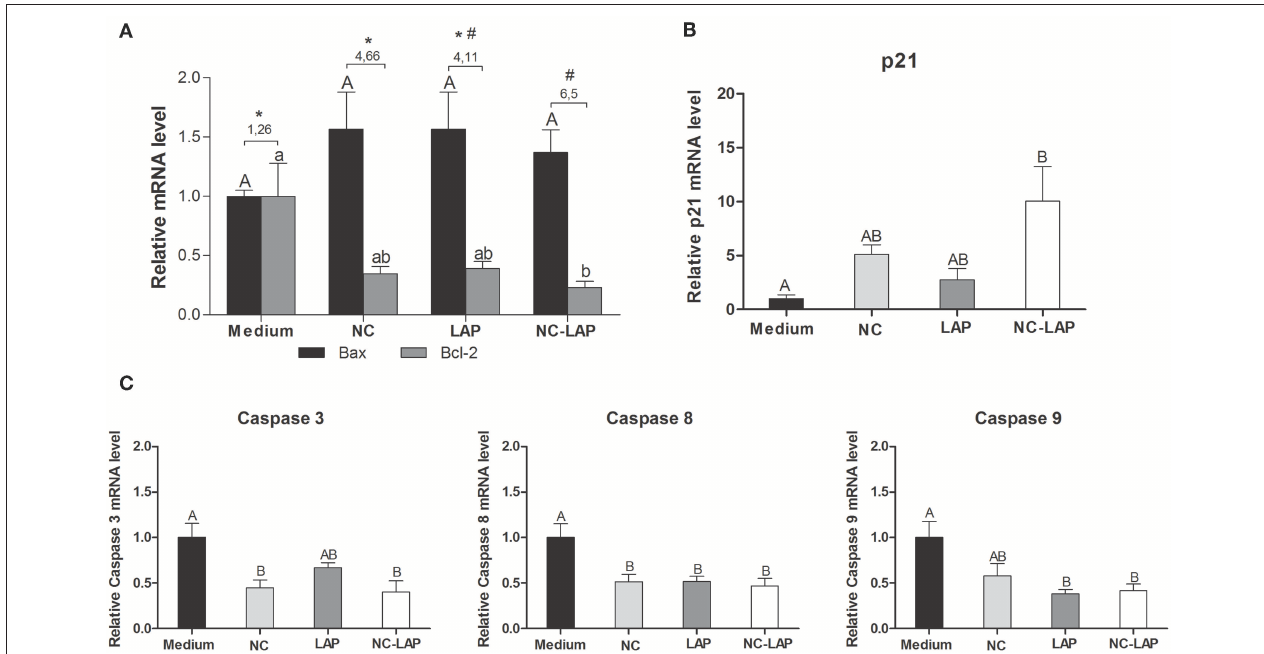
FIGURE 6 | NC-LAP increased Bax/Bcl-2 ratio and led to up-regulation of p21 in T-24 cell line after 6h of treatment. The gene expression profile was determined by qRT-PCR and data were normalized using GAPDH levels. (A) Proapoptotic (Bax) and Antiapoptotic (Bcl-2) gene expression. (B) p21 expression gene. (C) Expression levels of caspase 3, 8, and 9 after 6h. Data are represented by the means ± SEM from three independent experiments. The one-way ANOVA with Tukey post-hoc was used to analyze statistical significance. Significance was considered at P < 0.05. Significance was considered at P < 0.05. Different letters indicate significant differences between the means and different symbols (* and #, asterisk and sharp, respectively) indicates difference in the Bax-Bcl-2 ratio levels between